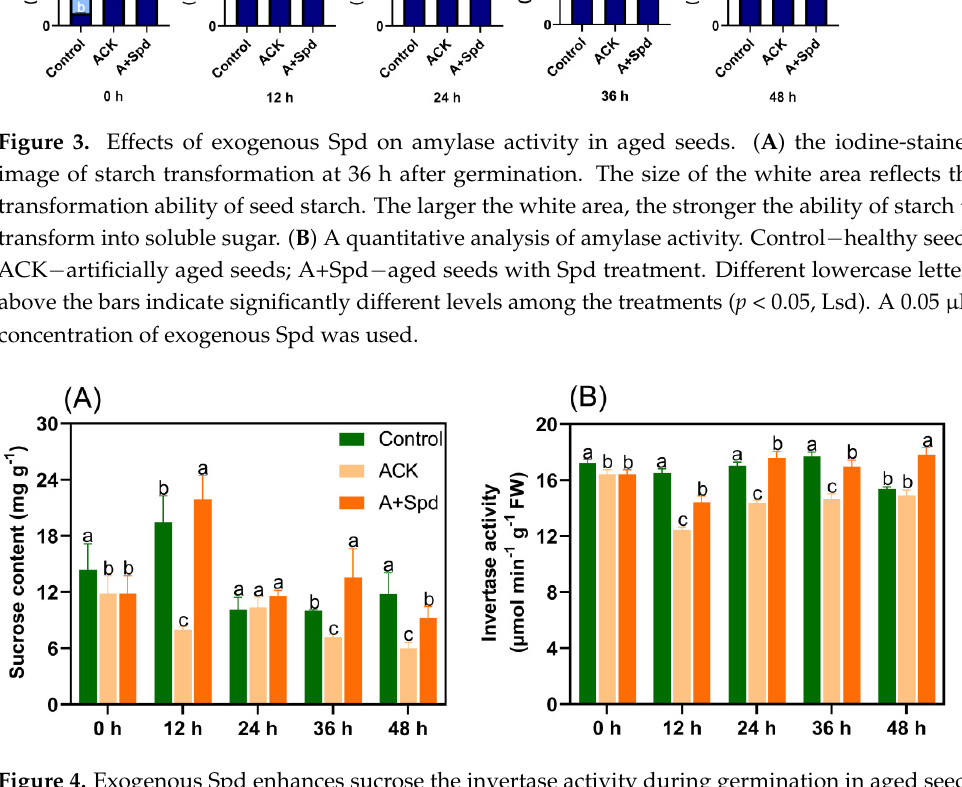
Figure 4. Exogenous Spd enhances sucrose the invertase activity during germination in aged seeds. ( A ) the quantitative analysis of sucrose content. ( B ) The quantitative analysis of sucrose invertase activity. Control − healthy seeds; ACK − artificially aged seeds; A+Spd − aged seeds with Spd treatment. A total of five time points from 0 to 48 h after germination were performed for each treatment. Different lowercase letters above the bars indicate significantly different levels among the treatments ( p < 0.05, Lsd). A 0.05 μ M concentration of exogenous Spd was used.